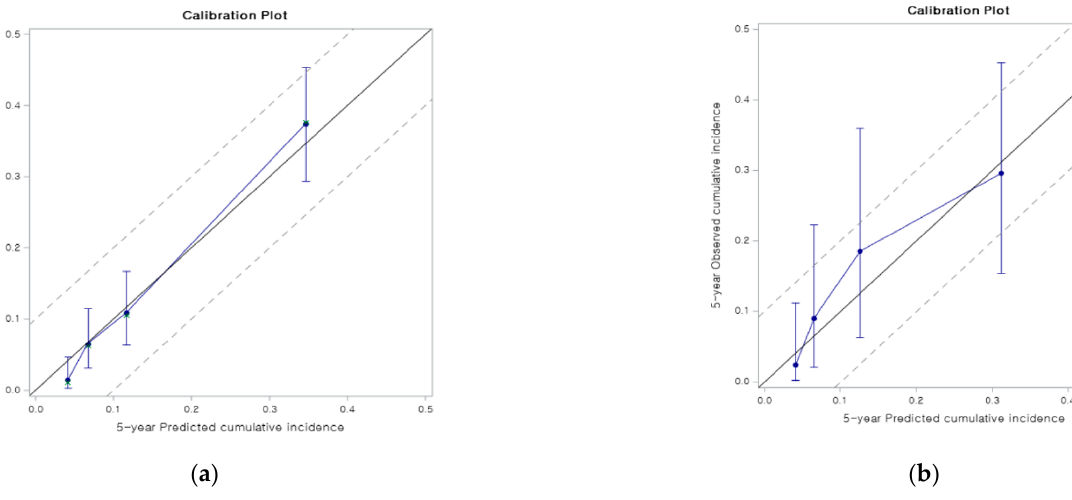
Figure 2. Internal and external validations of the developed model. The model shows reasonable discrimination with Uno’s c-index of calibration and slopes in internal ( a ) and external ( b ) validation. Table 3. Uno’s c-Index for the internal and external validation of the developed model.